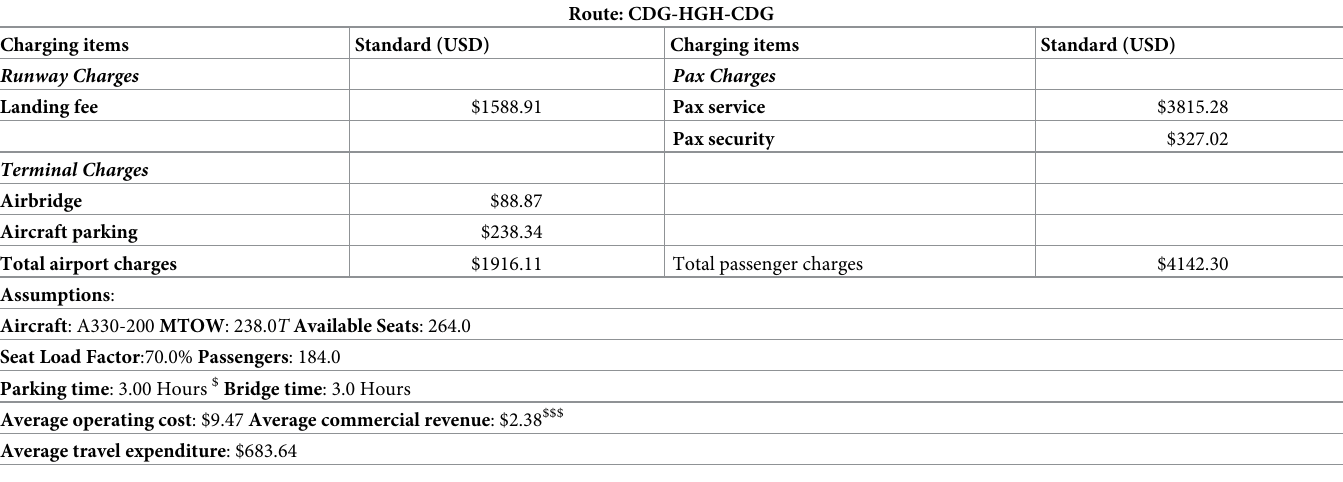
Table 3. Basic charging fee for one